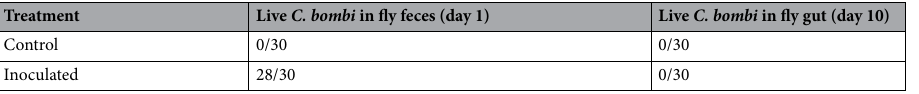
Table 1. Proportion of inoculated and control Eristalis tenax flies with live Crithidia bombi cells in first fecal events (day 1) and guts 10 days